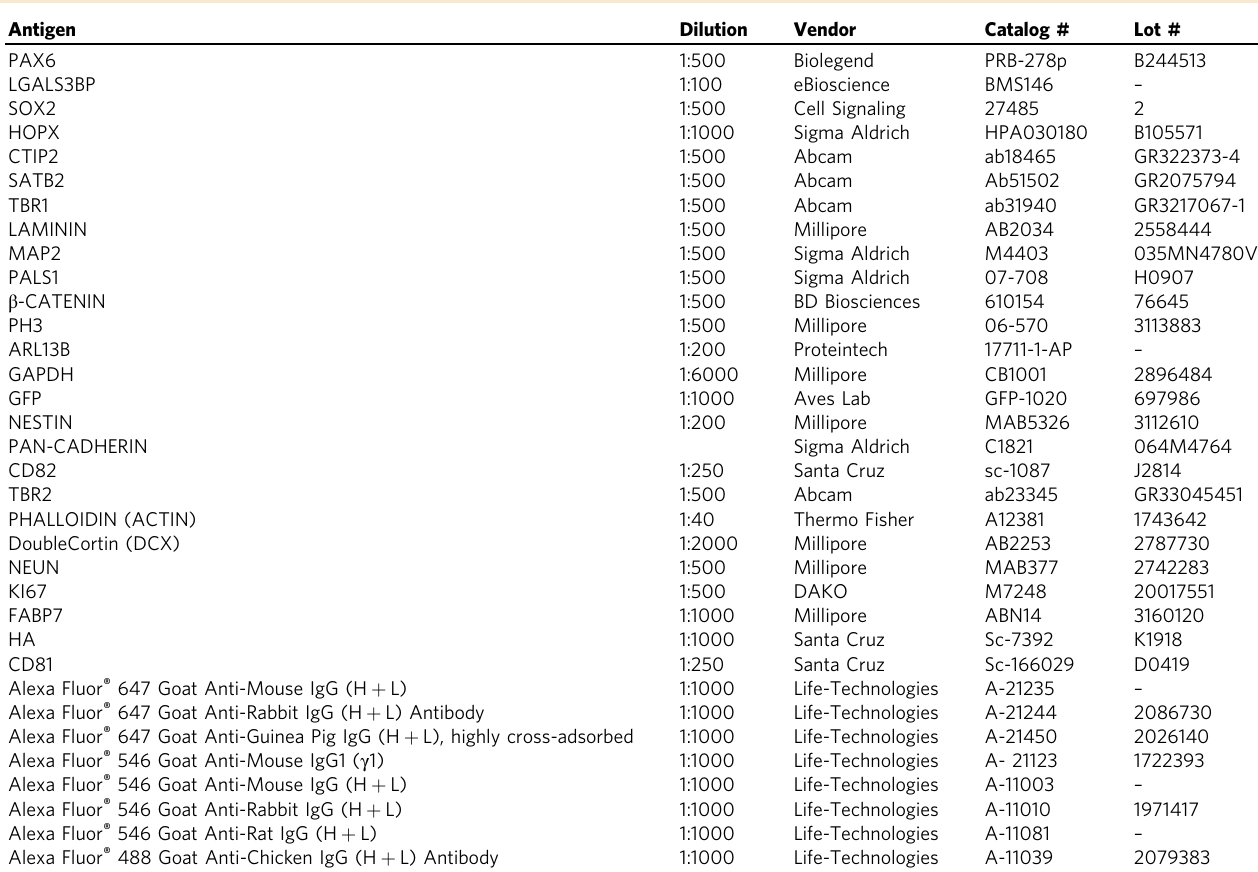
Table 1 List of antibodies